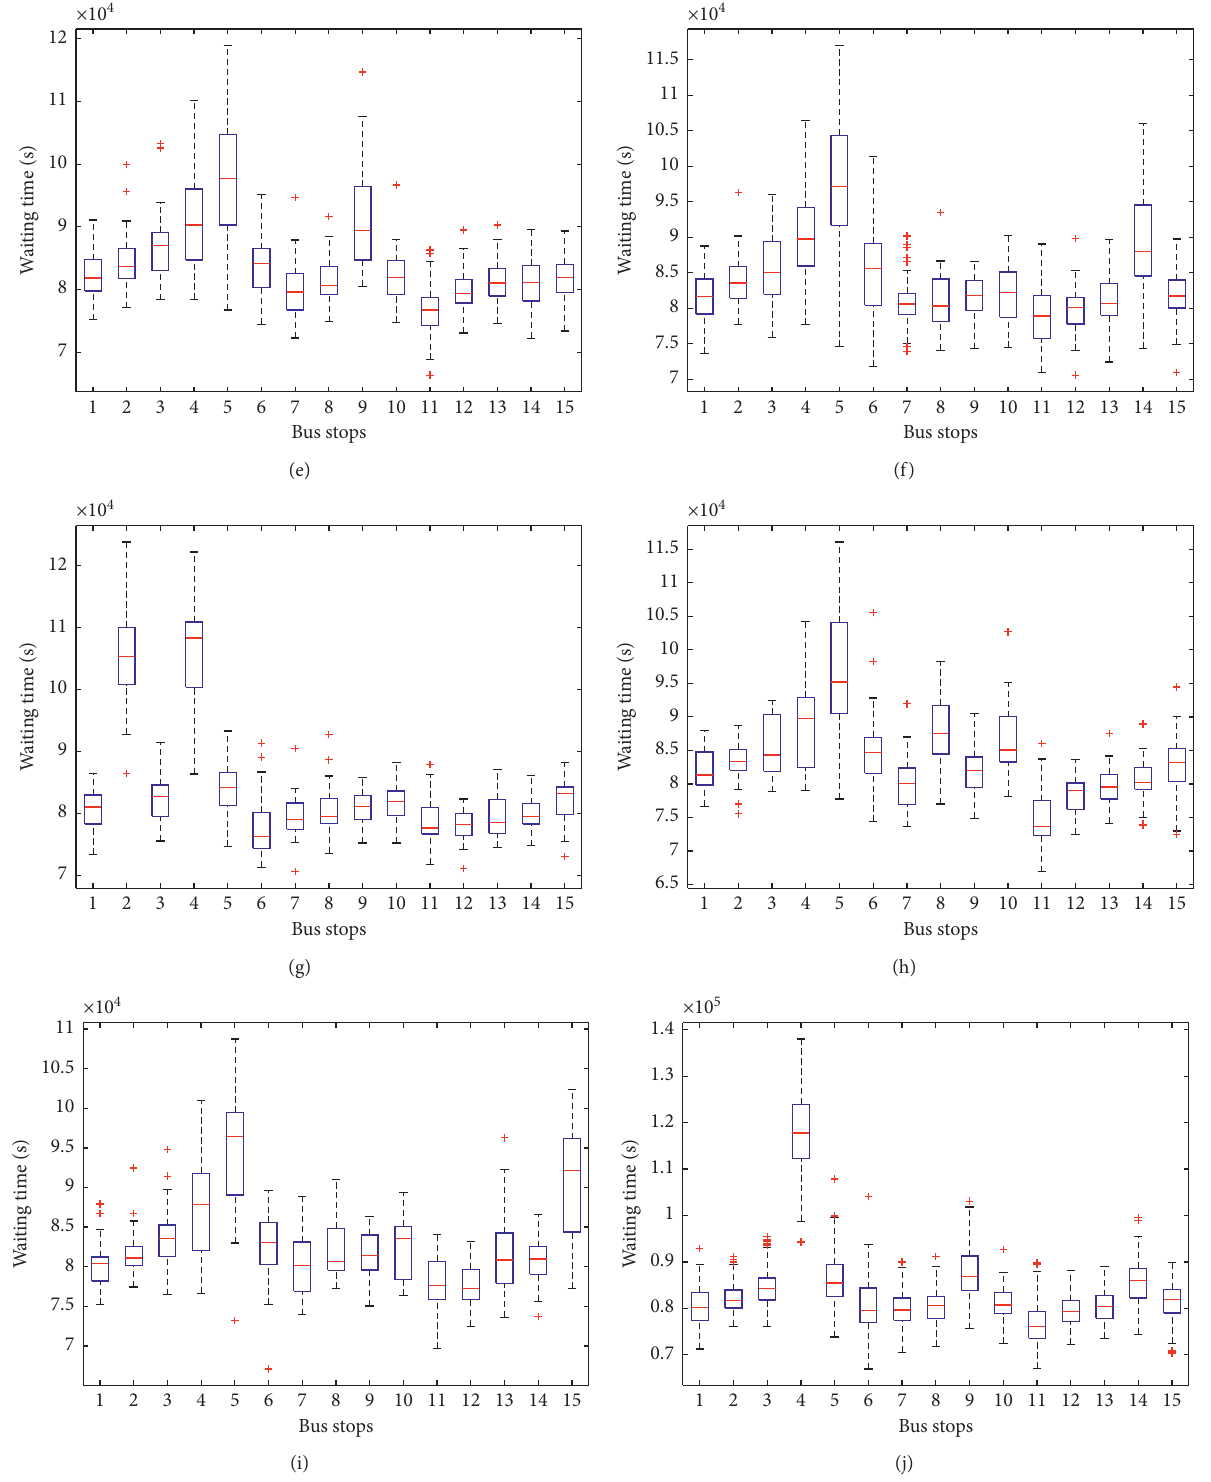
Figure 8: Waiting time of passengers at bus stops. (a) S1. (b) S2. (c) S3. (d) S4. (e) S5. (f) S6. (g) S7. (h) S8. (i) S9. (j) stop 5 the waiting time was the largest. The first reason is that Figure 8(a) presents the waiting time of passengers at bus the bus headways become more chaotic gradually when stops when the CPH locate at bus stop 6 and bus stop11, and running at the bus route, and unequal bus headways lead to the CPS locates at bus stop 6. At beginning of the five bus more waiting time. However, this is not the ultimate reason stops from 1 to 5, the waiting time increased gradually; at bus